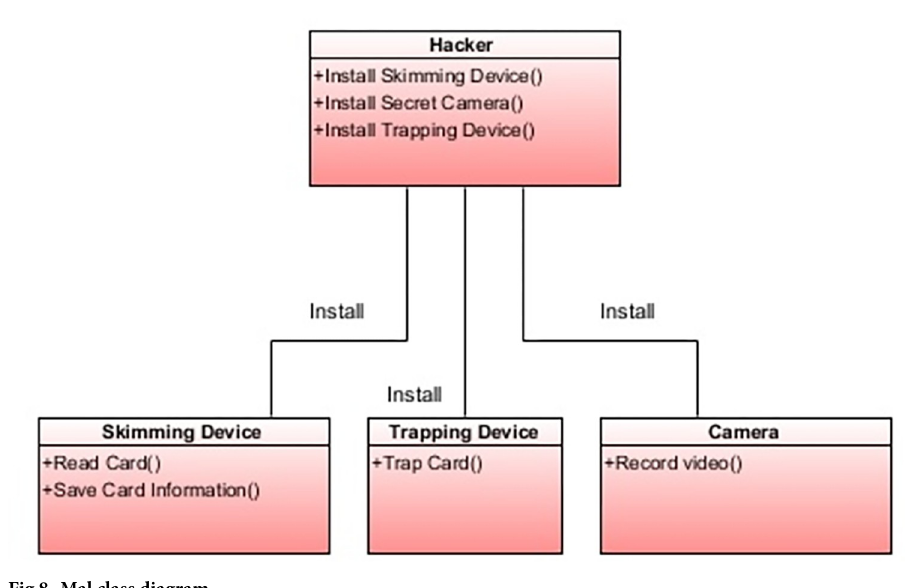
Fig 8. Mal class